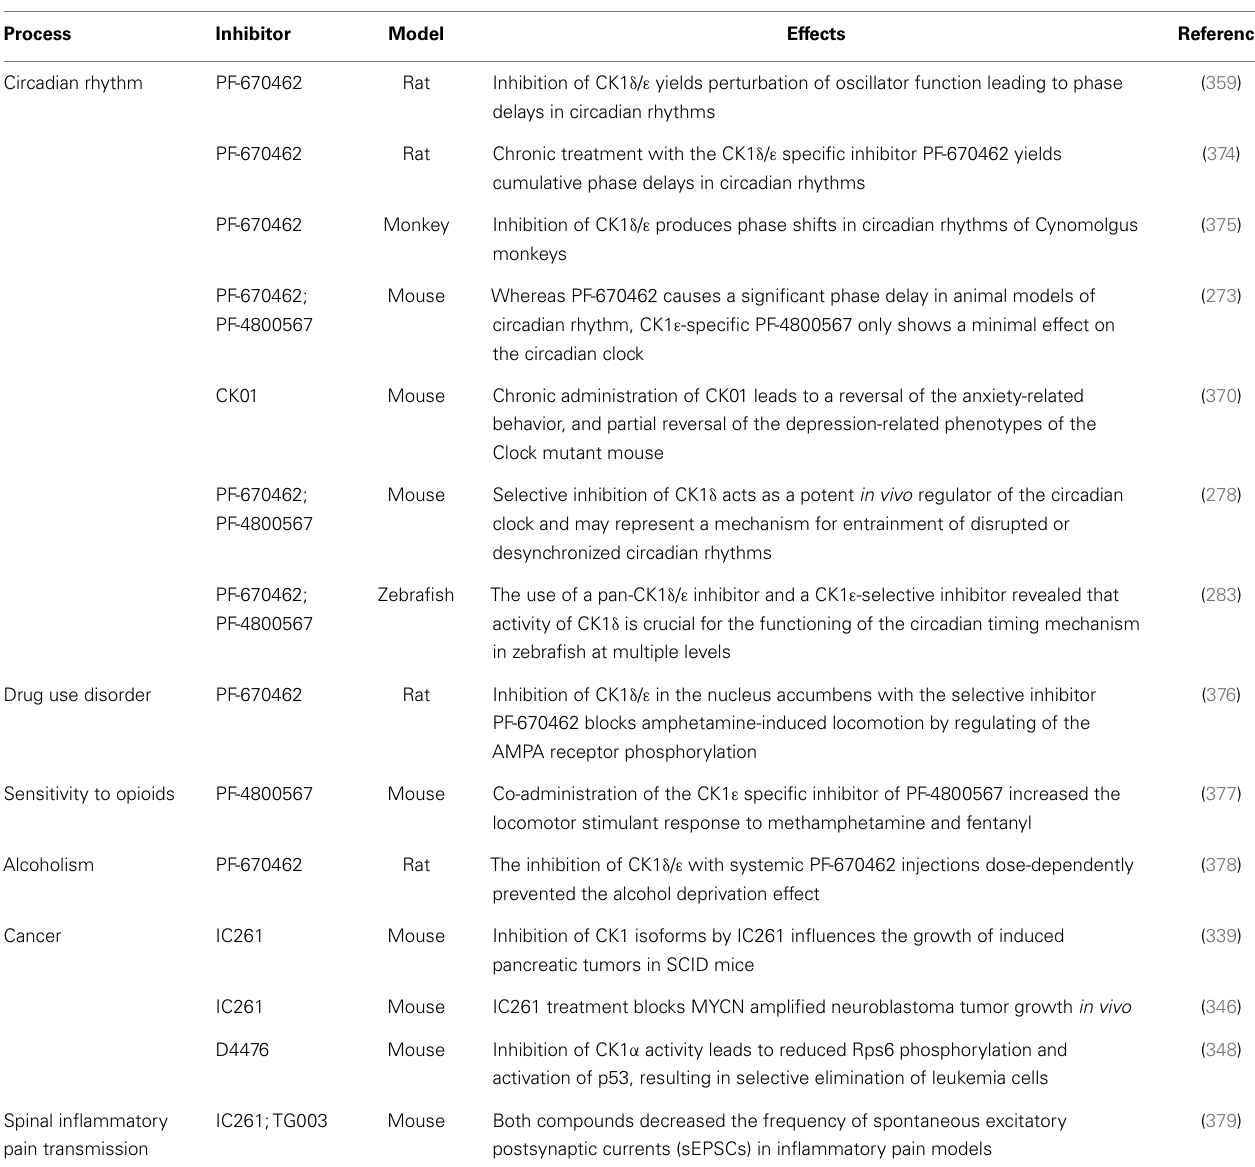
Table 4 | Effects of CK1-specific inhibitors in selected animal models